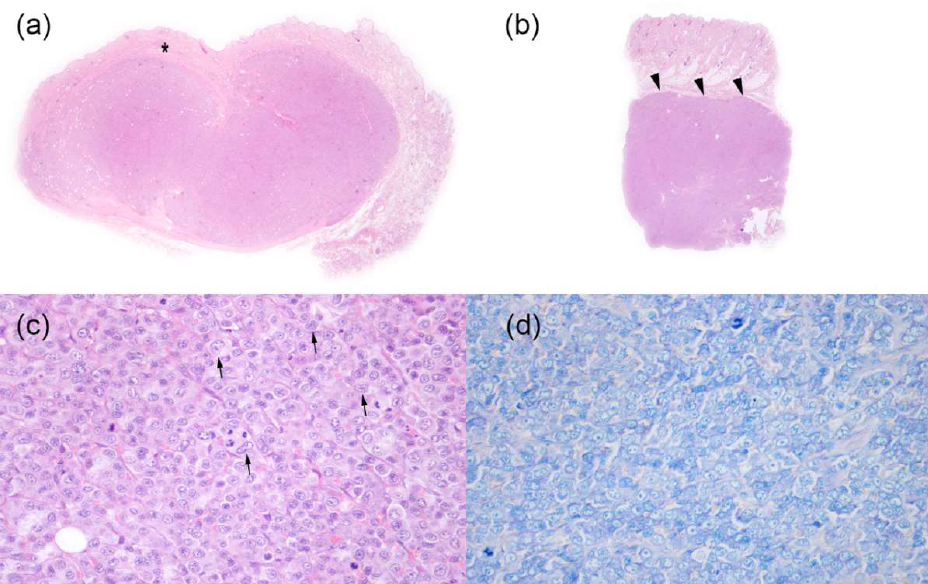
Figure 3. Histopathological findings of skin nodules in a 12-year-old non-neutered male Beagle with cutaneous non epitheliotropic B-cell lymphoma (CNEBL) vs. multiple cutaneous plasmacytosis (CP). ( a ) * Subgross images of one nodule from the right inguinal region. Neoplastic cells are expanding the mid and deep dermis (asterisk) extending to the subcutaneous tissue (Hematoxilin-eosin, 1.25×). ( b ) Subgross images of the nodule of the proximal region of the left paw. Neoplastic cells are invading and expanding the subcutaneous tissue (arrowheads) (Hematoxilin-eosin, 1.25×). ( c ) The tumor was composed of densely packed round cells, with eosinophilic cytoplasm, and large, frequently indented nuclei (arrows) with vesicular chromatin and prominent nucleoli (Hematoxilin-eosin, 40×). ( d ) Tumor cells do not show the presence of intracytoplasmic metachromatic granules (Giemsa, 40×).